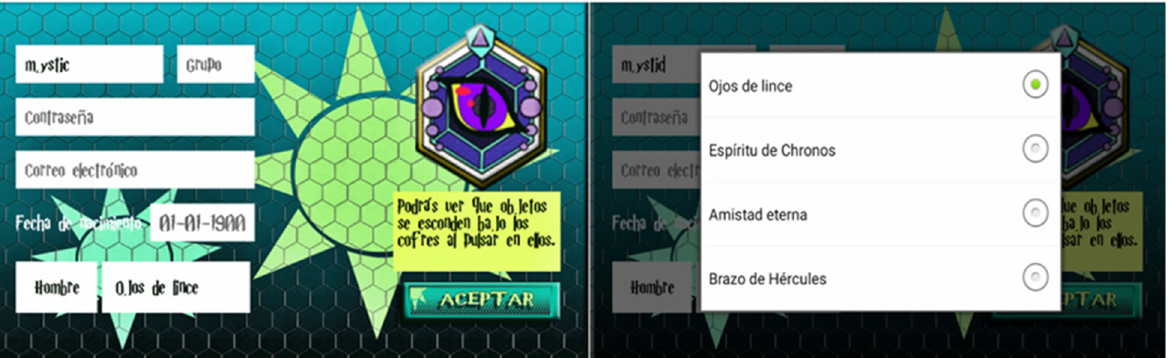
Figure 2. User registration and special skill selection (Spanish